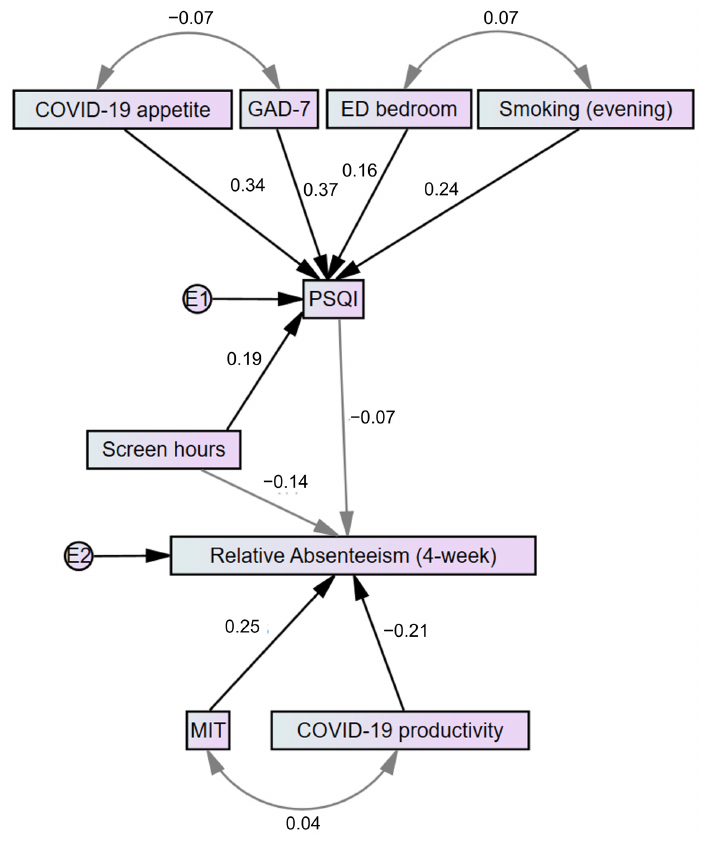
Figure 3. A path analysis representing the main findings regarding sleep quality and absenteeism. Gray-coloured lines indicate relationships that are non-statistically significant. Numbers indicate either beta-coefficients in a respective regression model or correlation coefficients (single and two- headed arrows, accordingly). E—error; ED bedroom—the use of electronic devices in the bedroom; GAD-7—Generalized Anxiety Disorder Scale-7; MIT—medium-intensity training; PSQI—Pitts- burgh Sleep Quality Index.